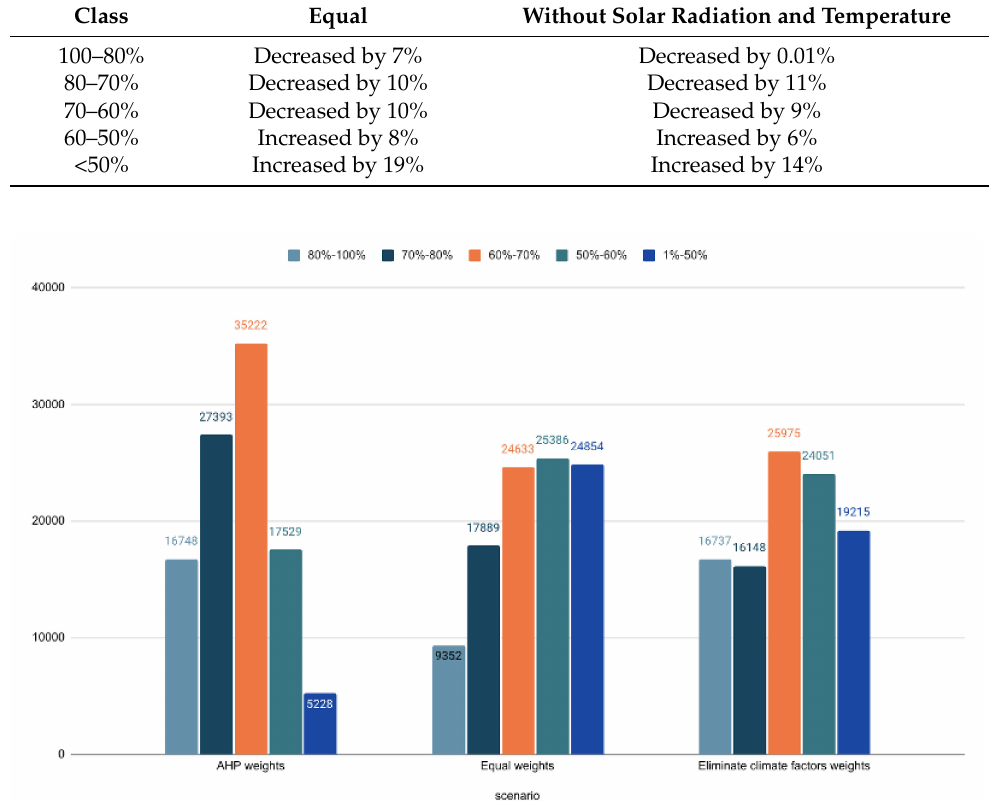
Figure 15. Area in km per suitability (comparison of suitability and sensitivity analysis